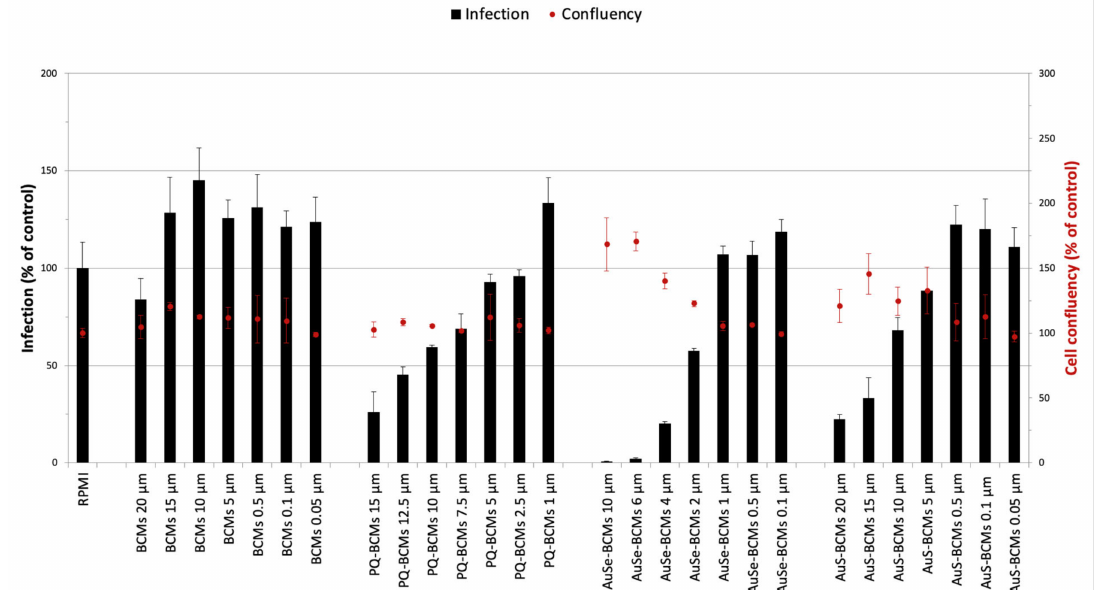
Figure 8. In vitro activity of encapsulated Au(III) bis(dithiolene) complexes against P. berghei hepatic infection. The inhibitory activity of primaquine-block copolymer micelles (PQ-BCMs), [PPh 4 ][AuSEt(=Se)]-block copolymer micelles (AuSe-BCMs), and [PPh 4 ][AuSEt(=S)]- block copoly- mer micelles (AuS-BCMs) is represented as a percentage of relative luminescence units of BCMs control. Compound cytotoxicity was measured by fluorescence following AlamarBlue addition and normalized to the RPMI control. Results are expressed as a mean ± the standard